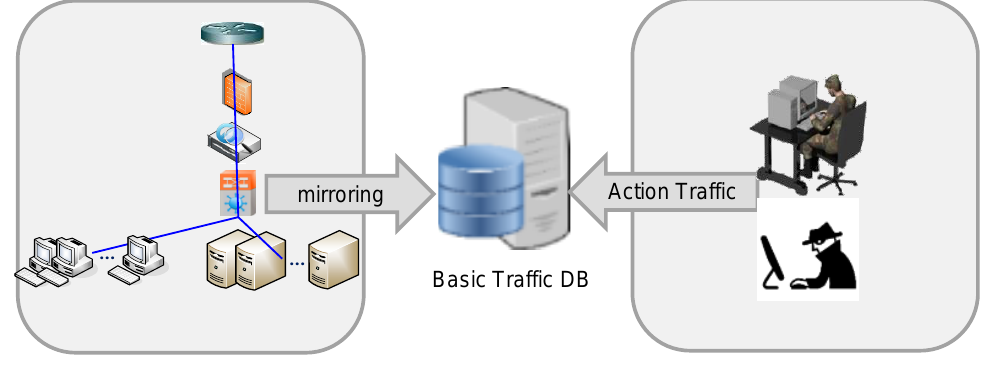
Figure 8. Collect real operation traffic.